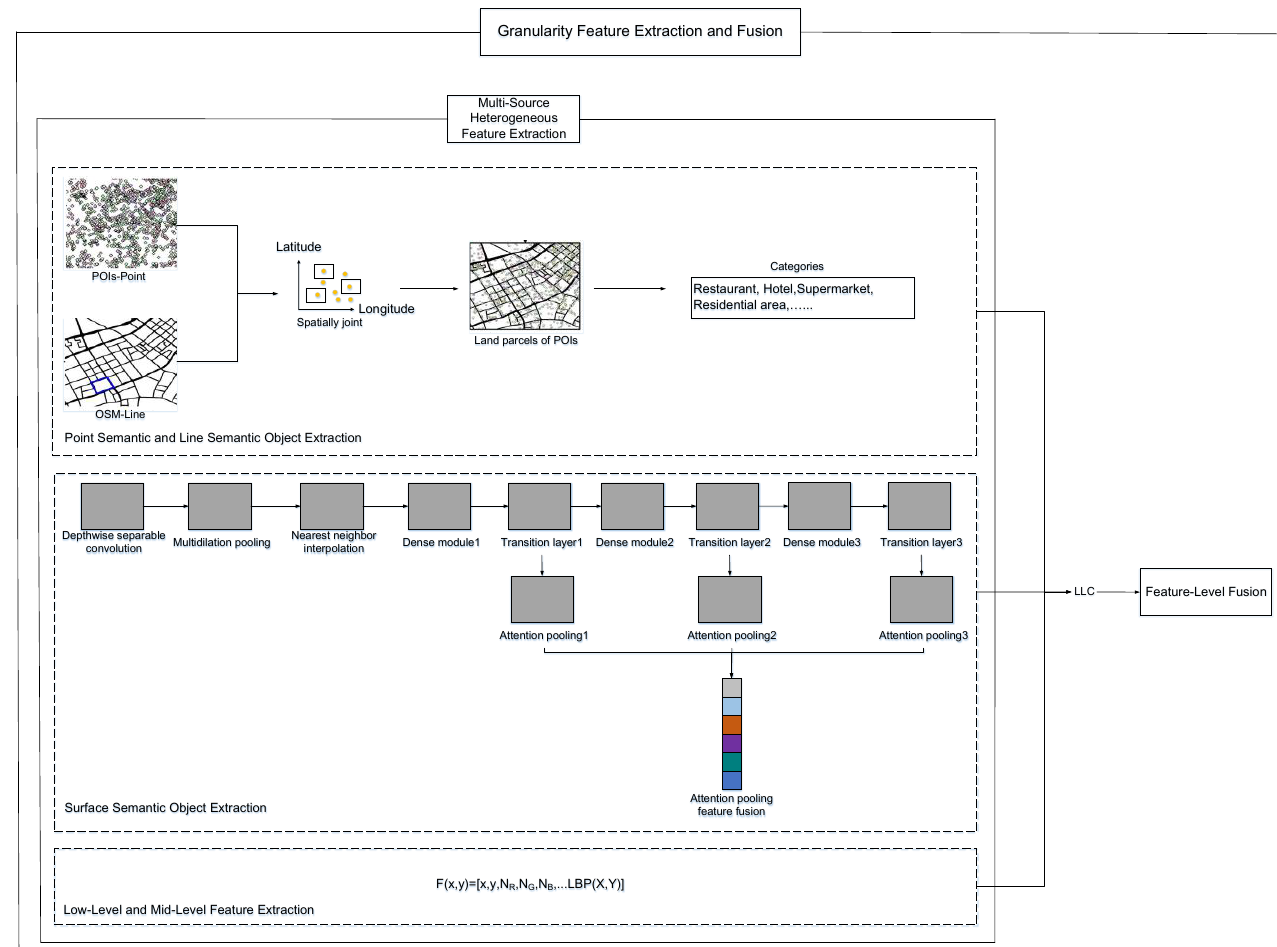
Figure 6. Granularity feature extraction and fusion module. The module includes point semantic object extraction, line semantic object extraction, and surface semantic object extraction. The input of this module is the granularity of multi-scale grid sampling of HRRSI image, and the output is the multi-source heterogeneous